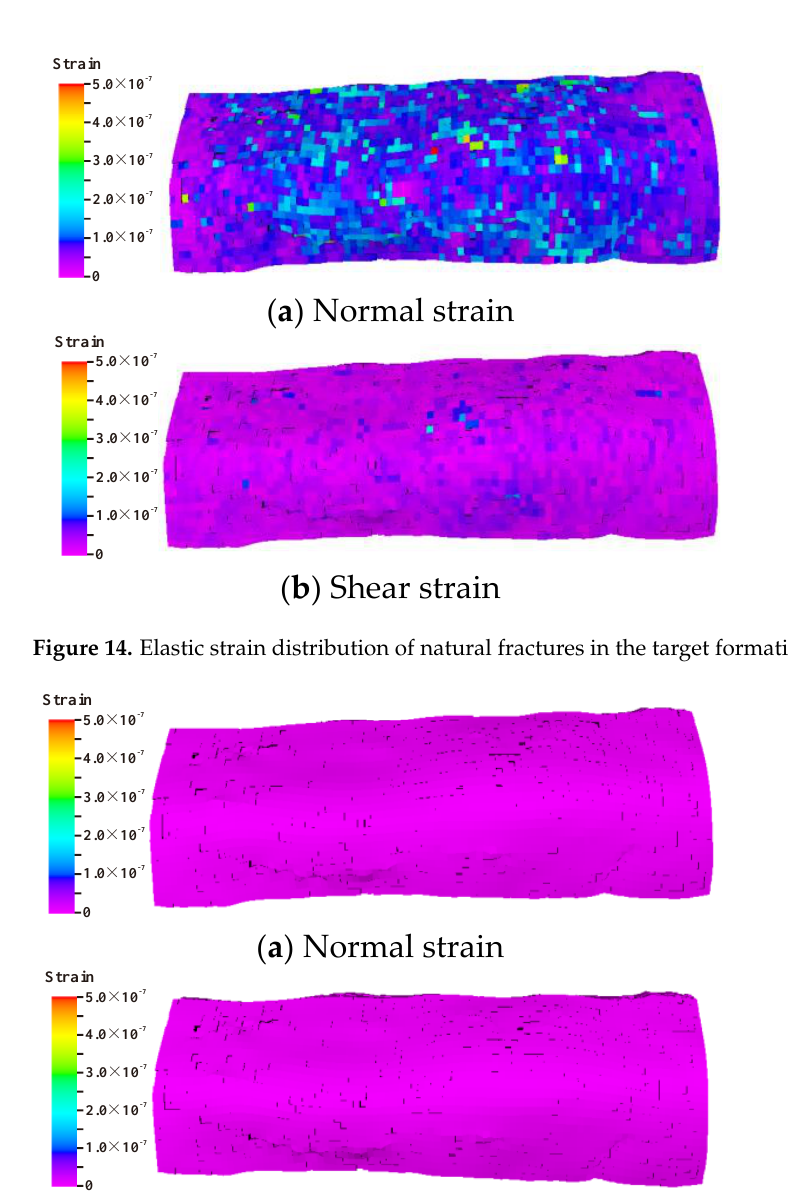
Figure 13. Plastic strain distribution of faults in the target formation.